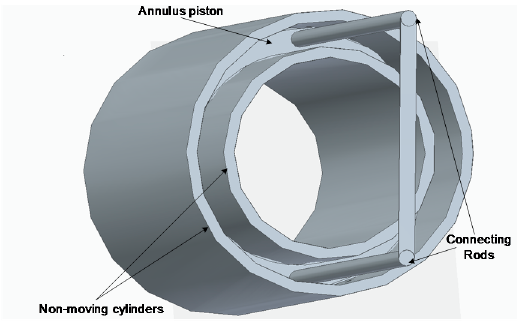
Figure 5. The proposed cylindrical internal fin that can be heated or cooled with connecting rods in the gap between the Franchot engine cylinder and the internal fin.